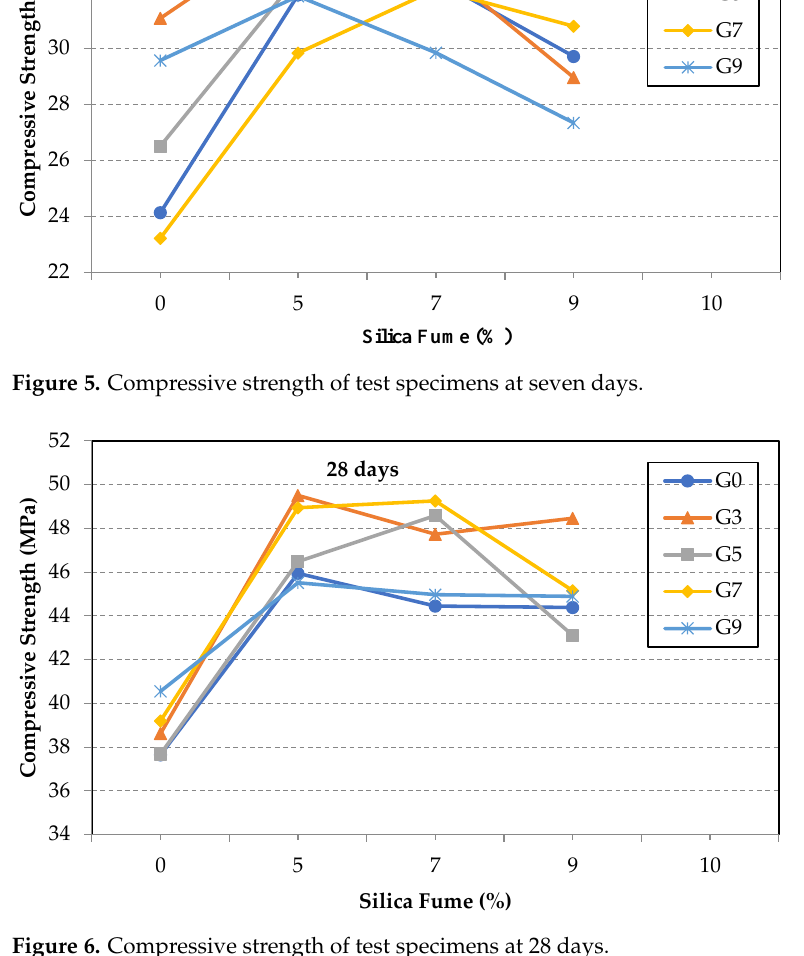
Figure 6. Compressive strength of test specimens at 28 days.